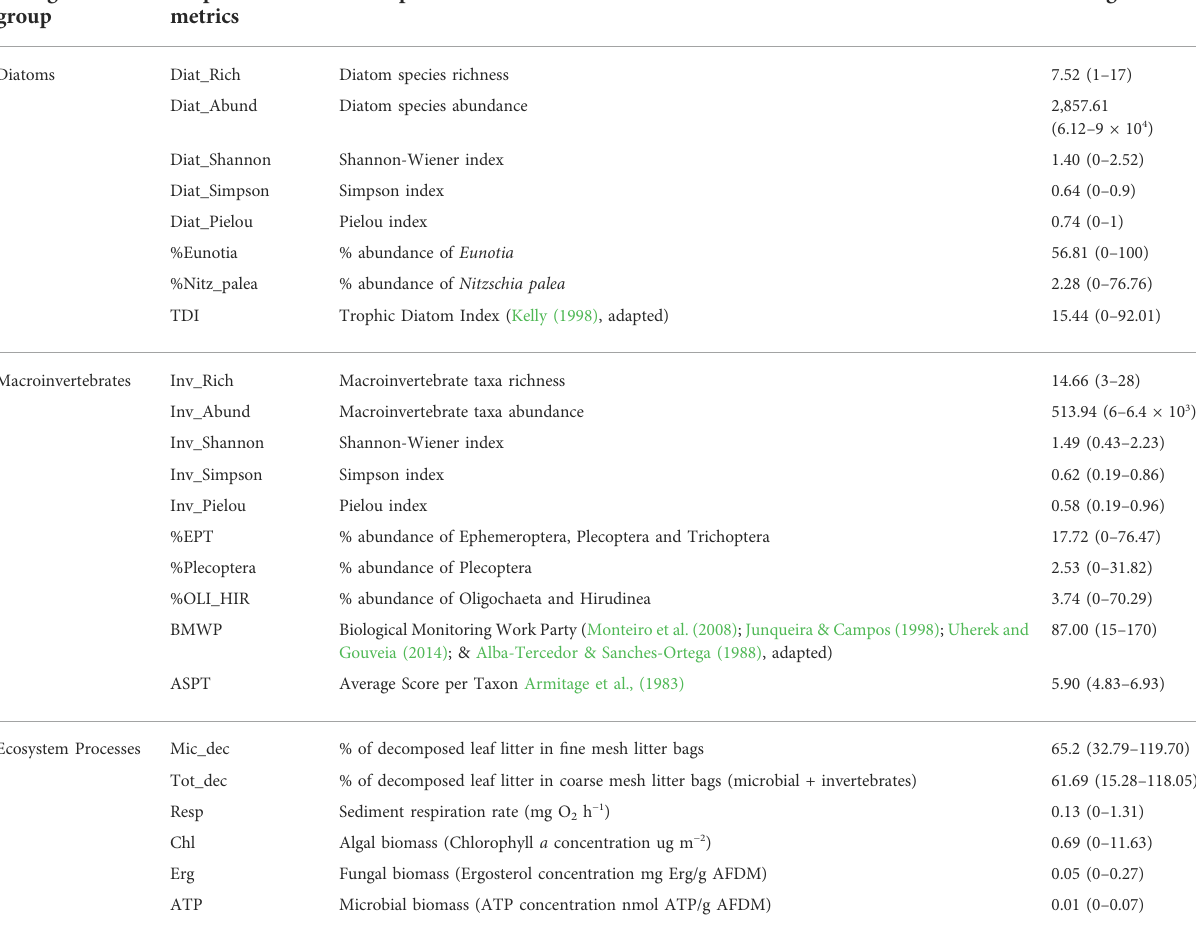
TABLE 2 Description, average and range (minimum and maximum) of ecological response metrics. Ecological